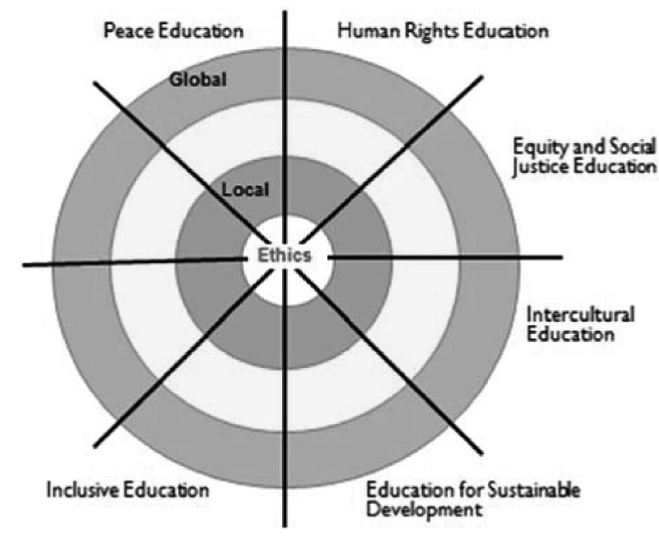
Figure 1: Education for Global Citizenship. Reproduced with the author’s permission from Räsänen, 2011: